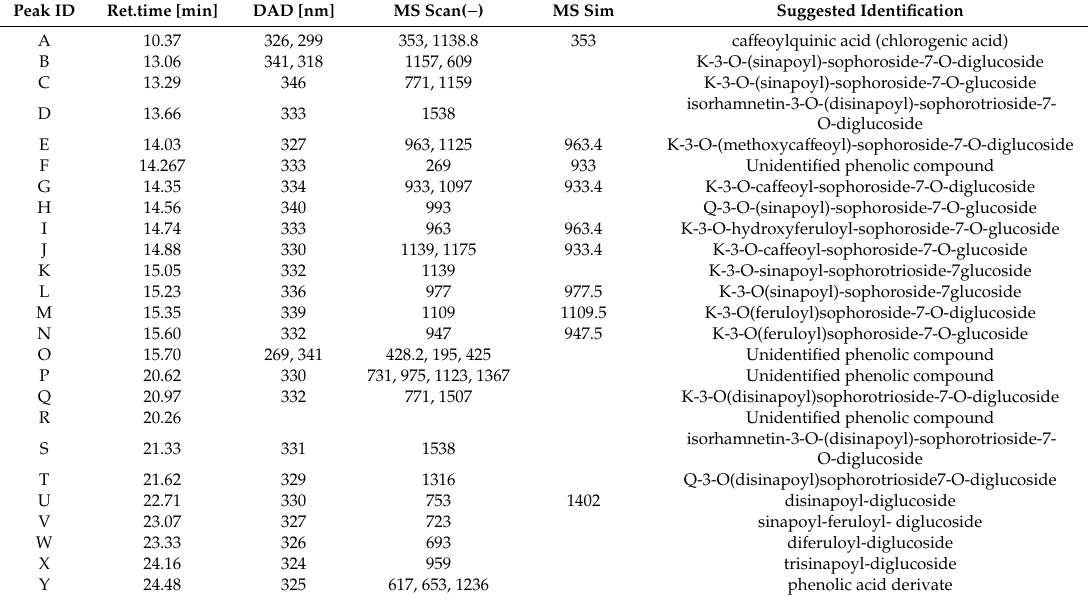
Table 5. Tentative identification of phenolic compounds in methanol extract of broccoli leaves Peak